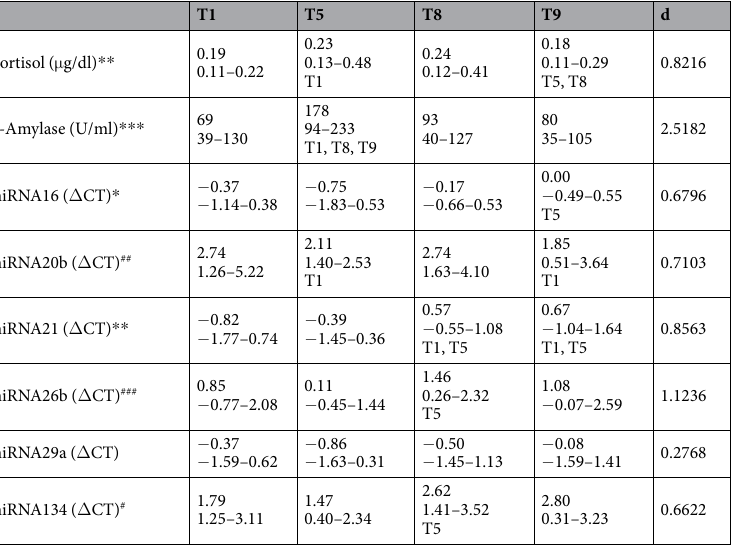
Table 3. Results of salivary cortisol, alpha-amylase and miRNAs. Median and IQR of parameters assessed at times T1, T5, T8, T9 and ‘Cohen d’ effect size. * p Friedman = 0.059; ** p Friedman < 0.05; *** p Friedman < 0.001. # p = 0.068; ## p < 0.05; ### p < 0.001. The first row lists median, the second row lists Skillings-Mack Skillings-Mack Skillings-Mack the 25%- and 75%- percentile (IQR). The lowermost row of each parameter lists significant differences to other time points (p < 0.05). (Remark: Δ CT-values are inverse to miRNA-concentrations in the samples: low Δ